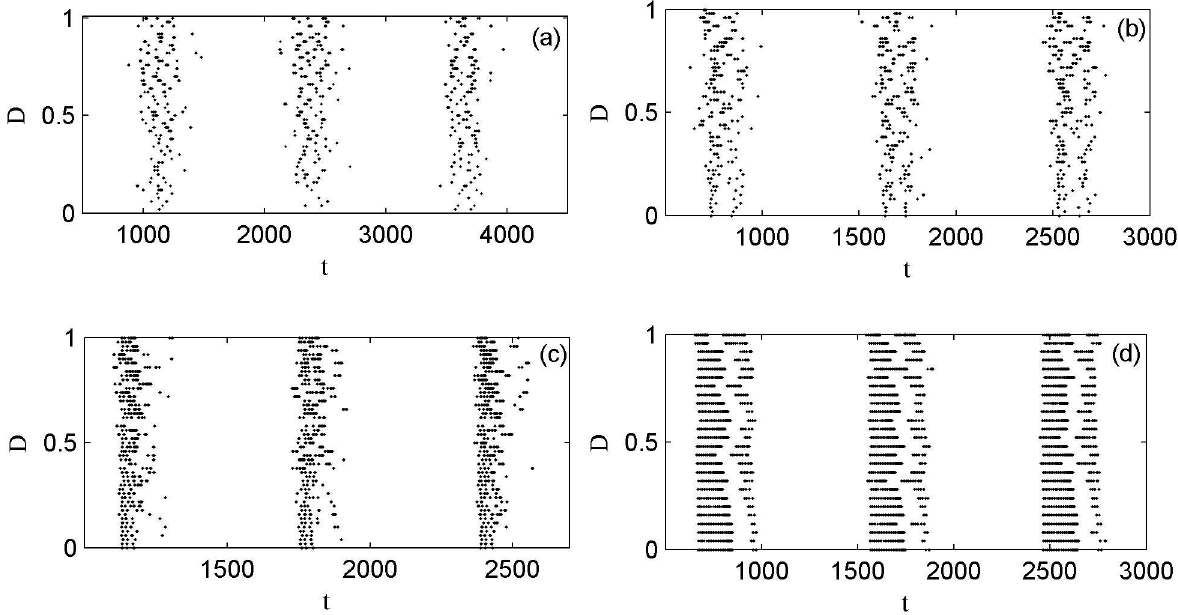
Fig 6. The time points of the neural firing as the Le´vy noise